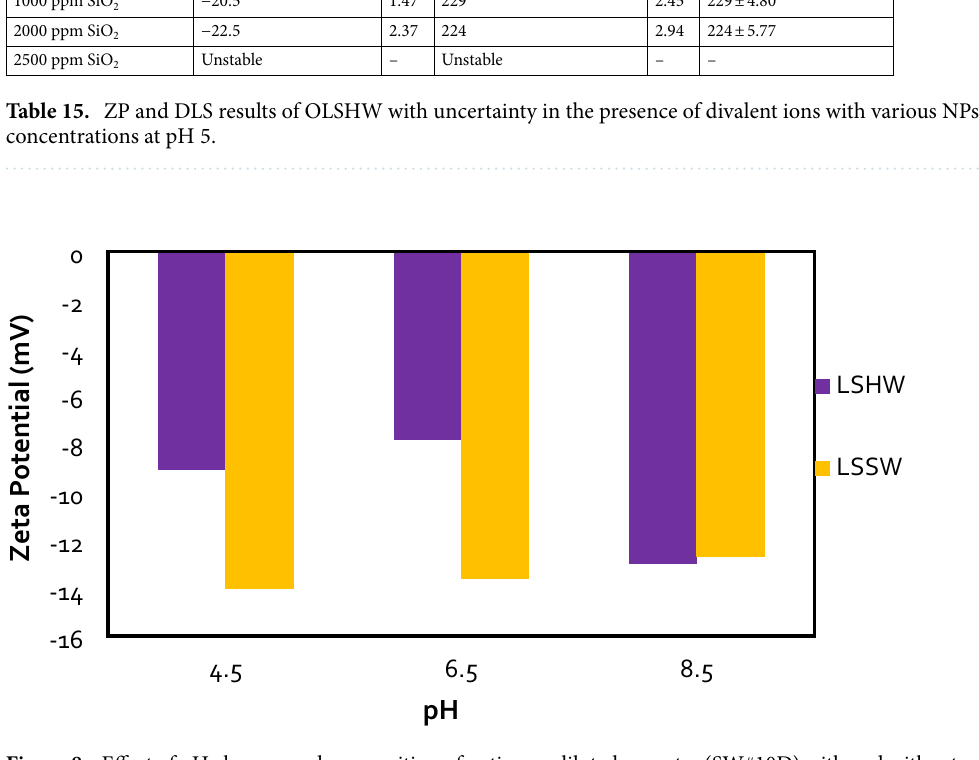
Figure 8. Effect of pH changes and composition of optimum diluted seawater (SW#10D) with and without divalent ions as LSSW and LSHW compositions on ZP